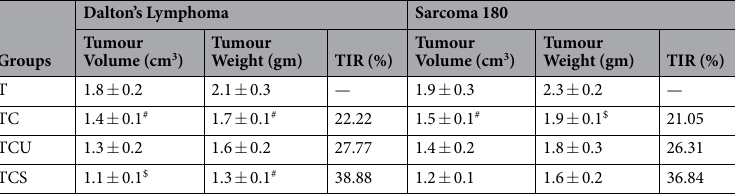
Table 4. Effect of MUS on growth of two different solid tumours in vivo . Data are represented as mean ± SD, n = 6. # Denotes (P < 0.01) and $ denotes (P < 0.05) as compared to the respective control group. Comparisons were made between T and TC group; whereas TCU and TCS were compared with TC